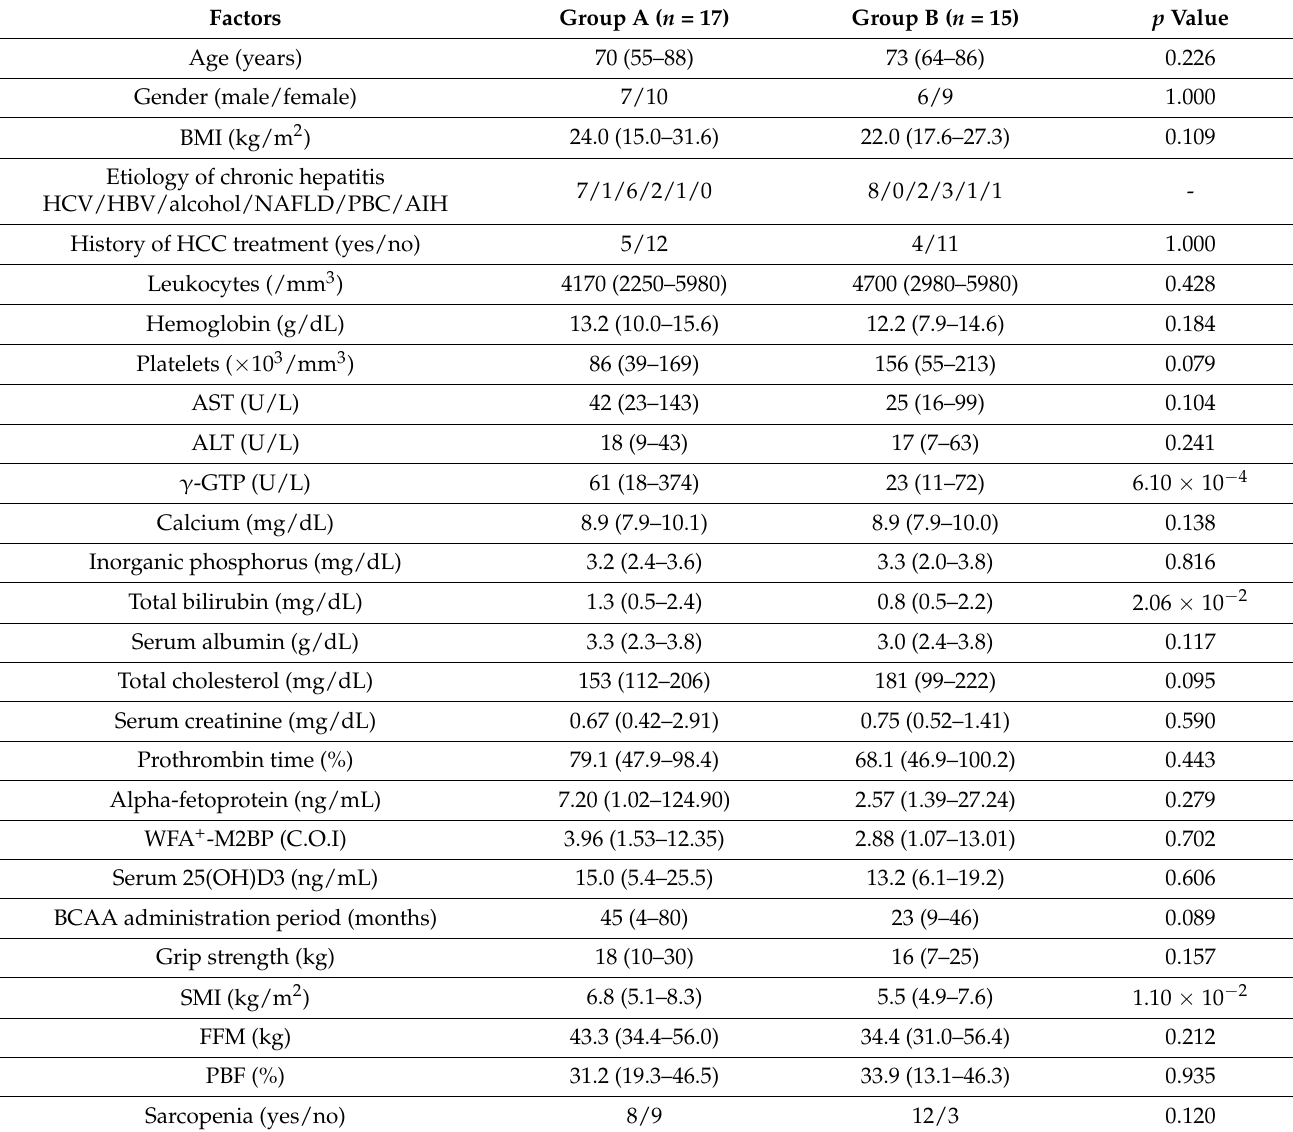
Table 1. Baseline patient characteristics of control group (Group A) and vitamin D supplementation group (Group